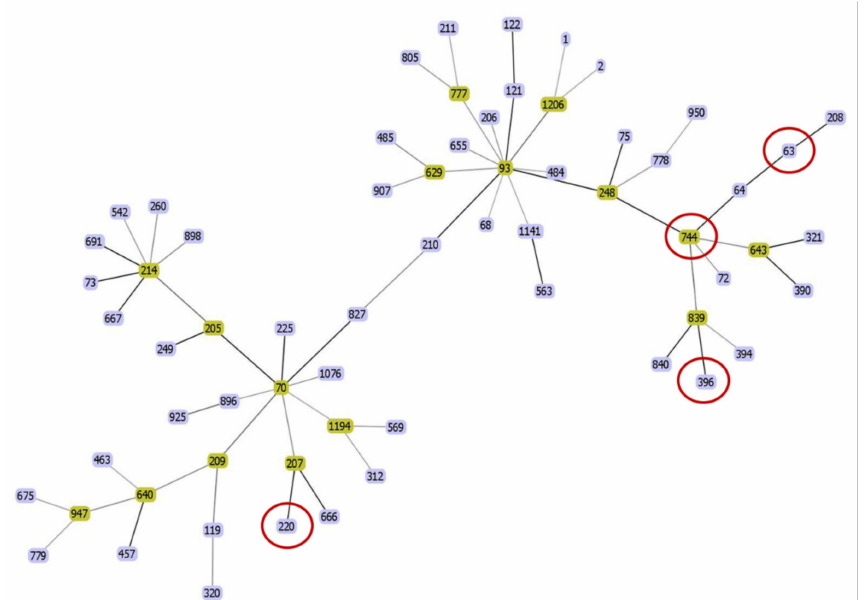
Figure 1. Minimum spanning tree of sequence types (ST) of 65 A. pittii , constructed with goeBURST. The seven CRAP isolates belonging to four STs are denoted as red circles.